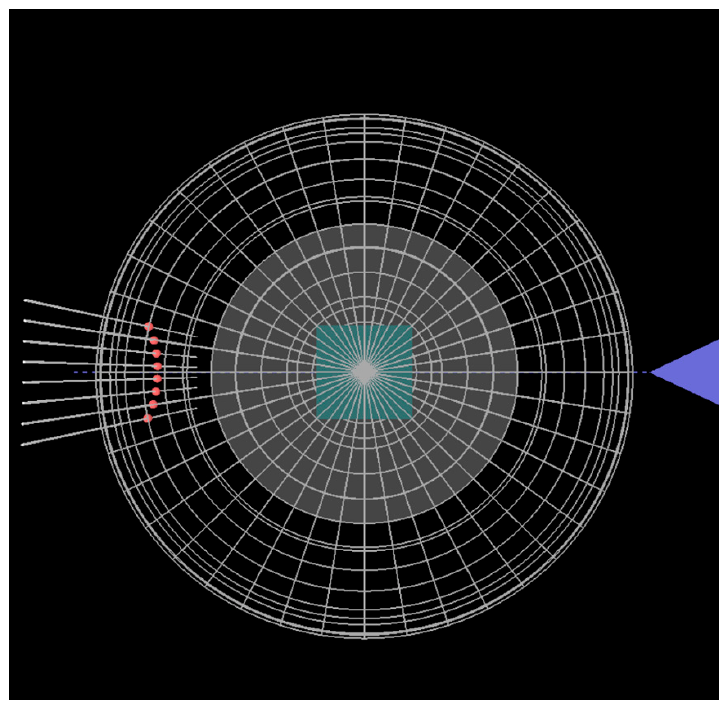
Figure 4. A skew view from a virtual camera that can be moved continuously to different observa ‐ tion points by a user of the application.